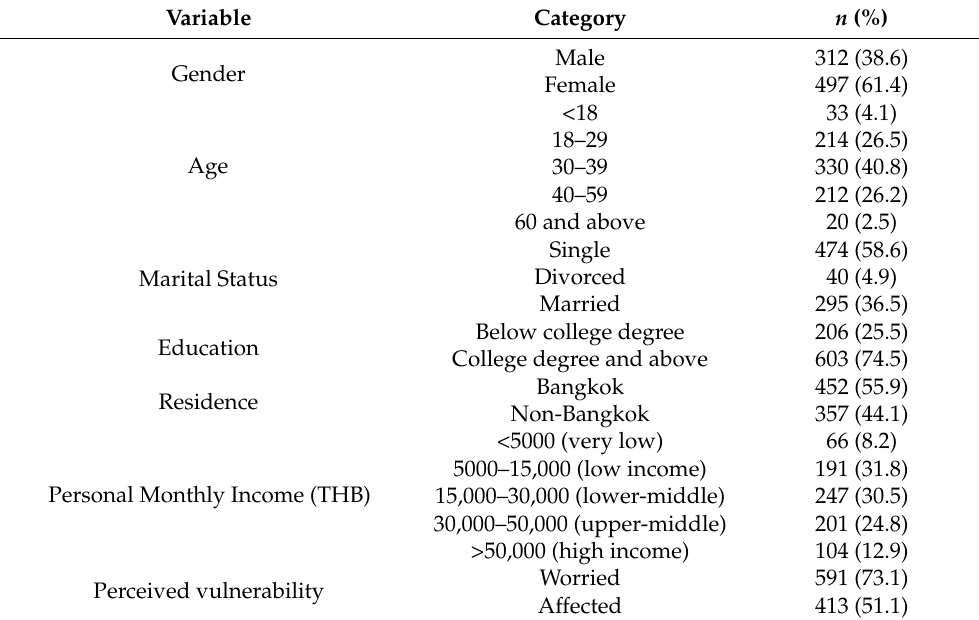
Table 1. Descriptive statistics of the demographic characteristics of the study population ( n =